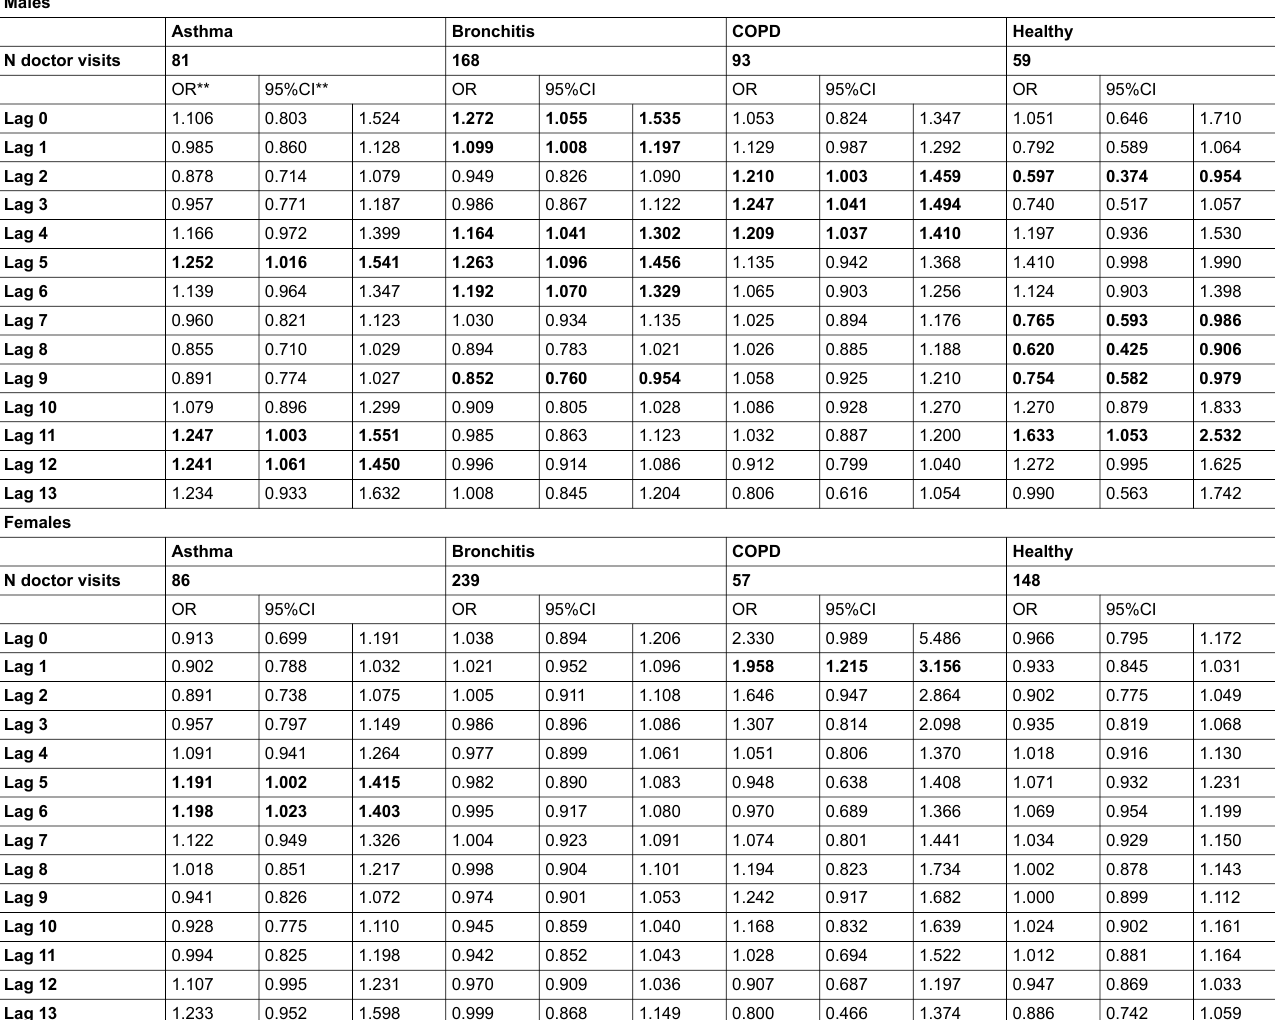
Supplementary file: Table 3 Adjusted OR's* for doctor’s visit for respiratory symptoms per 10 µg/m 3 increase in NO 2 after stratification by gender.